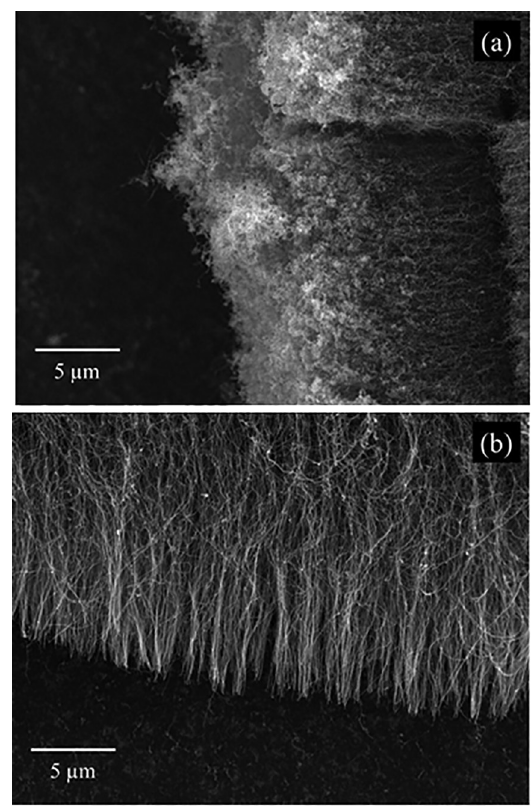
Figure 3: SEM images of CNTs grown at 800 and 900 °C on Zirconia